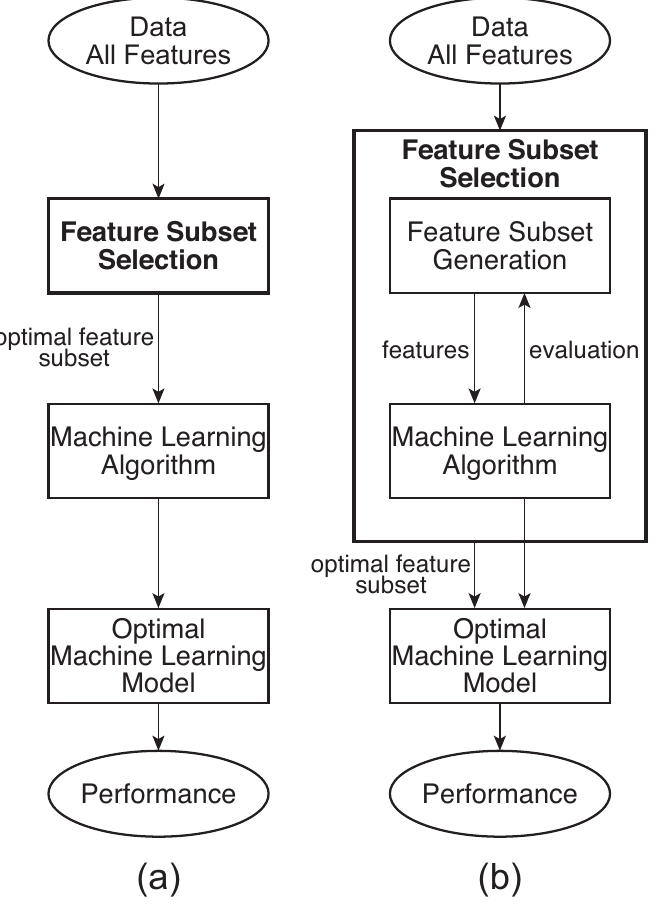
Figure 2. Dimensionality reduction and most relevant feature subset selection: ( a ) Filter method and ( b ) Wrapper